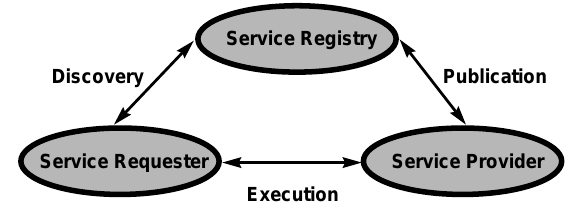
Figure 1. Traditional SOA